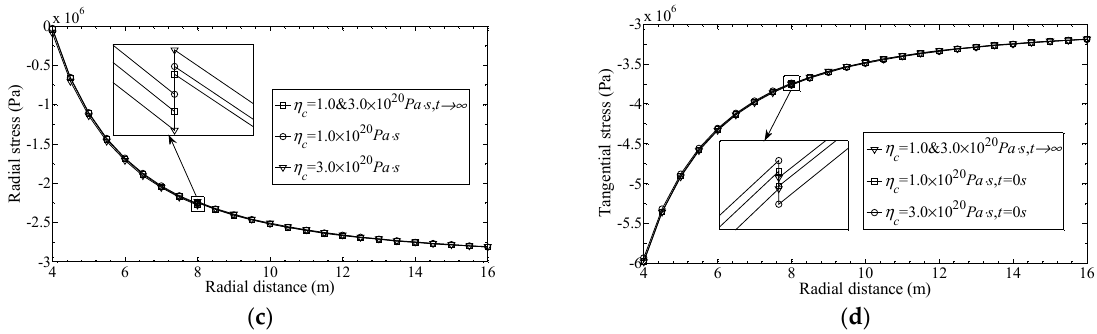
Figure 3. Mechanical states in experiments A and B. ( a ) Axial force–time curves; ( b ) Displacement–radial distance curves when the time equals zero or 6.0 × 10 9 seconds; ( c ) Radial stress–radial distance curves when the time equals zero or 6.0 × 10 9 seconds; ( d ) Tangential stress–radial distance curves when the time equals zero or 6.0 × 10 9 seconds.